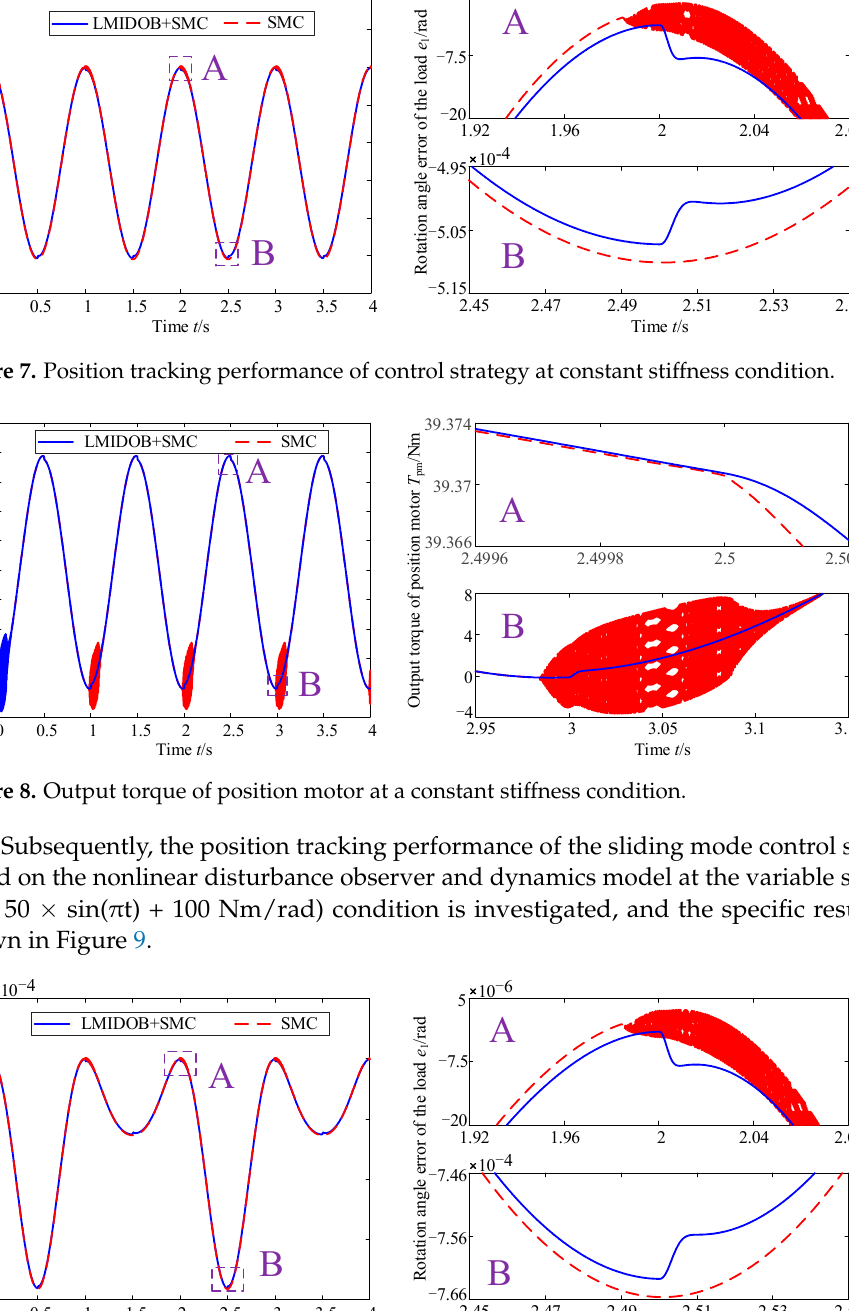
Figure 8. Output torque of position motor at a constant stiffness condition.